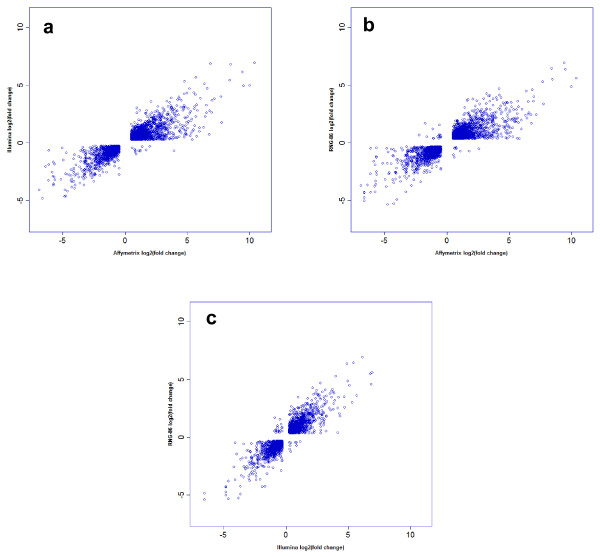
Correlation of fold changes. For each pair-wise comparison, Pearson's correlation coefficients of fold change were calculated and the direction of change was examined; Genes present in the top-left and bottom right quarters of each plots show changes in opposite direction. These genes are expected to overlap by chance.